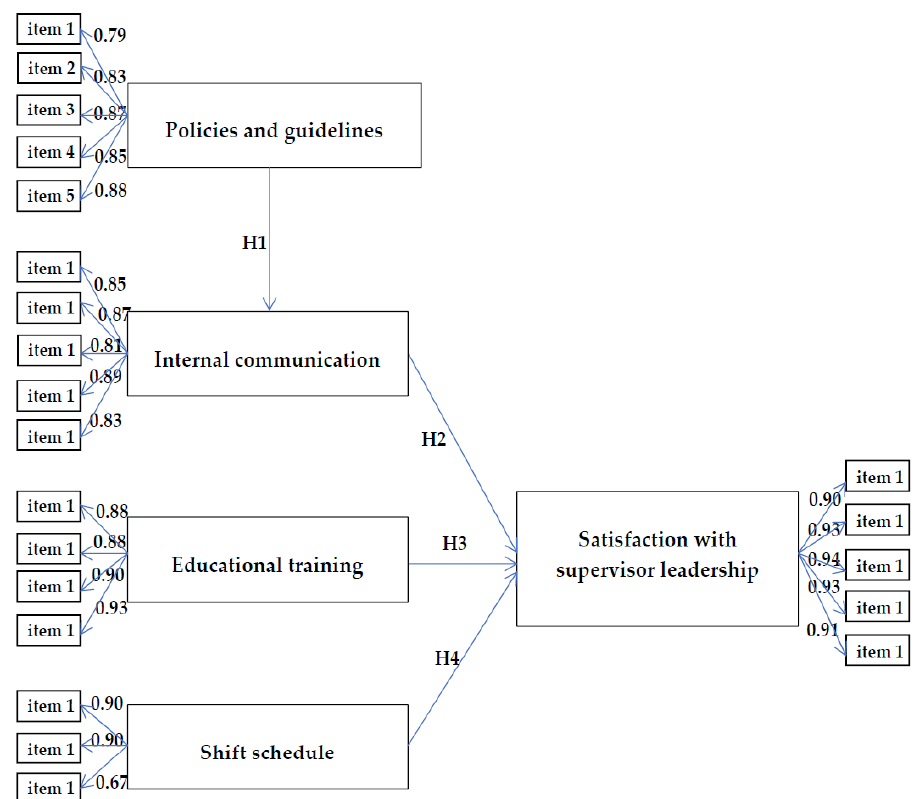
Figure 2. The finalized model reflects the relationships between various variables and nurses’ satisfaction with the supervisor leadership.